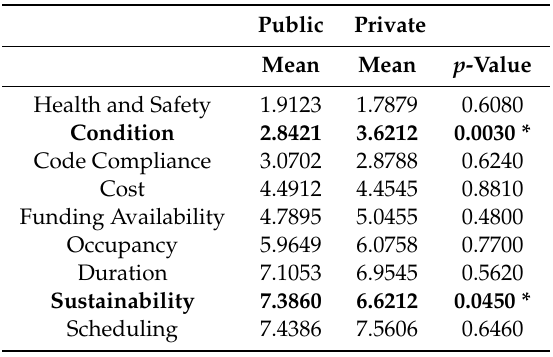
Table 4. Mean importance ranking and two-sample t -test p -values for private and public organization